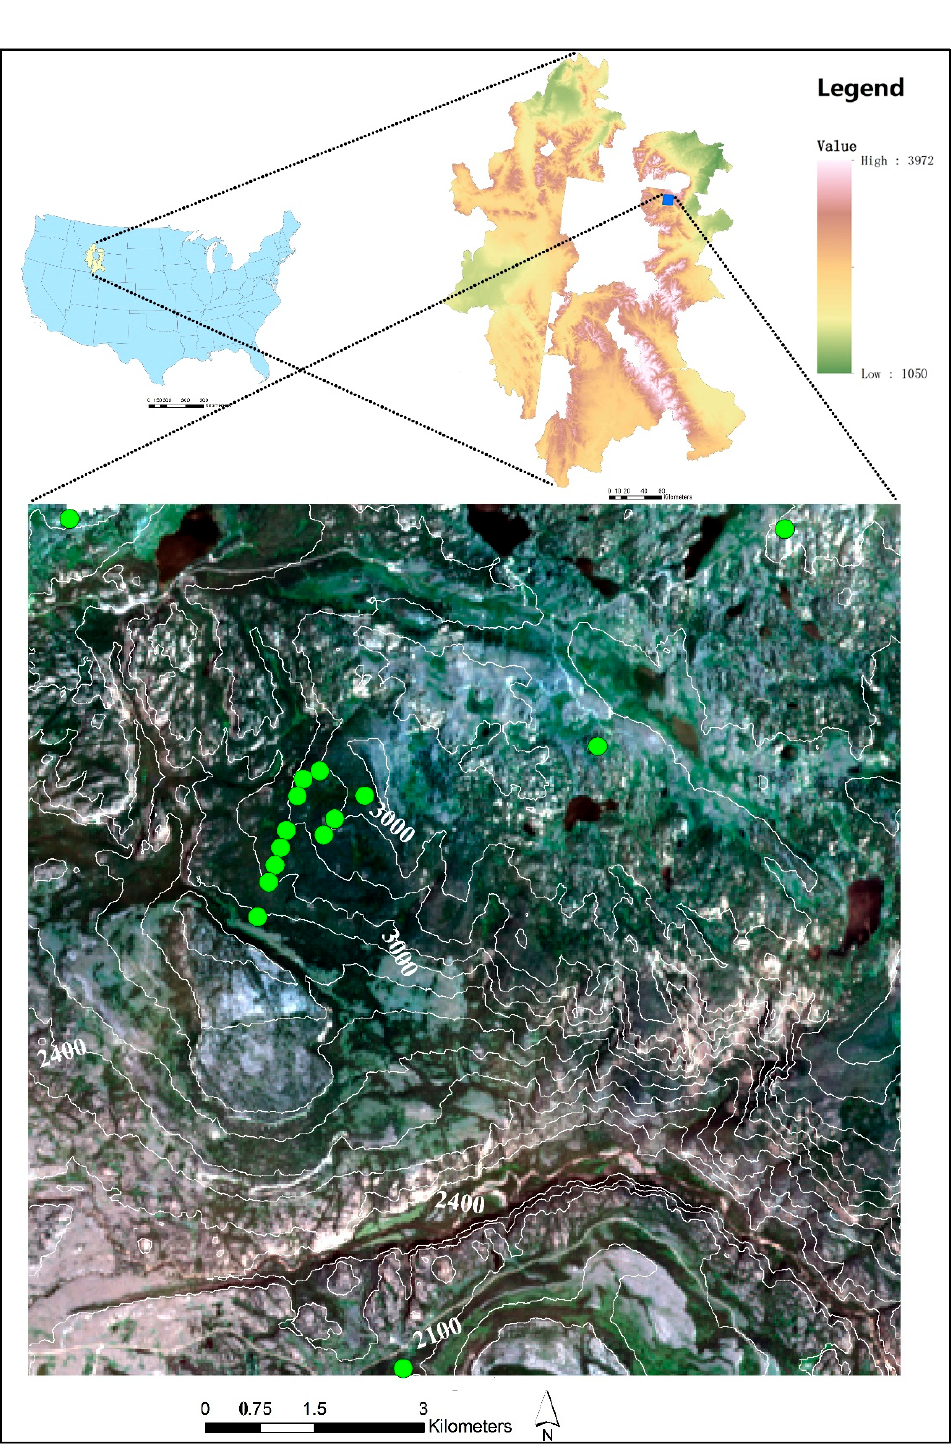
Figure 1. The study area is located in the mountainous area in the Greater Yellowstone Ecosystem. The green circles represent the final 15 plots that we chose for this study.